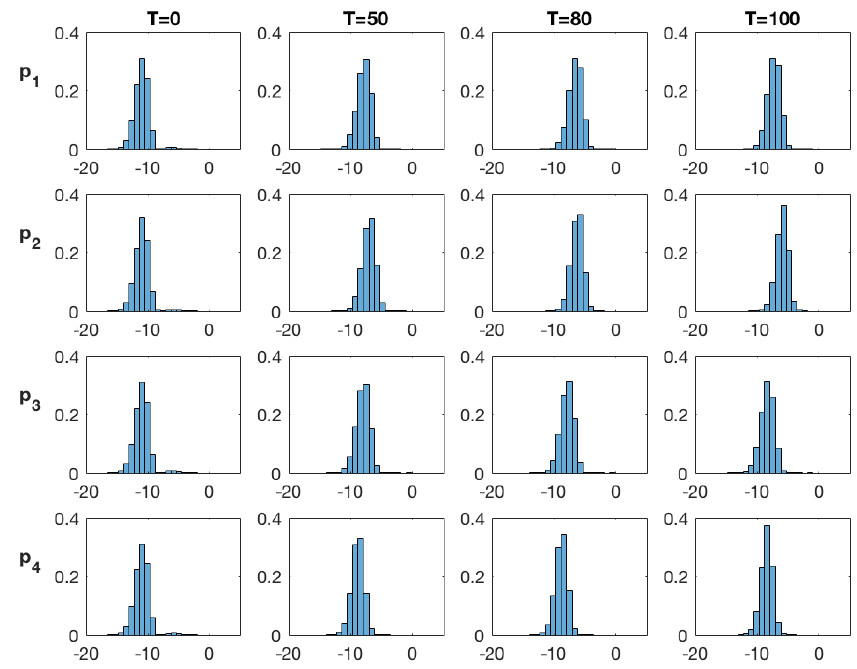
Figure 7. EnKF approach: Marginal posterior distribution of the log diffusivity f ( log ( λ i ) | d 0: T ) at time T = 0,50,80,100 at the monitoring locations (1,2,3,4) denoted ( p 1 , p 2 , p 3 , p 4 ).